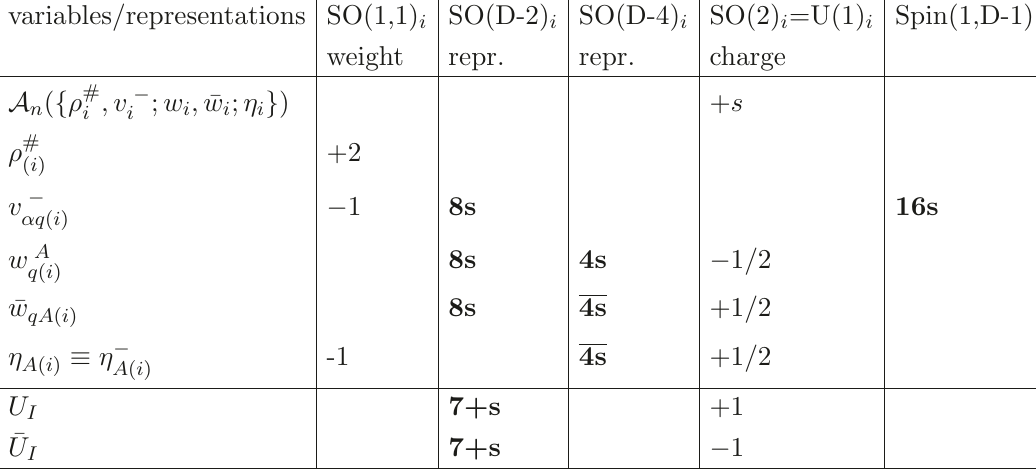
Table 1 . SO(D-4) and SO(D-2) representations, SO(1,1) weights and U(1) charges of the analytic superamplitude and its arguments; s = 1 for D=10 SYM and s = 2 for 11D SUGRA. U I and ¯ U I are bilinears of w and ¯ w as defined in (4.25) for D=10 and (5.41) for D=11. This table also indicates that the simplest superamplitudes (6.1) are Lorentz scalars, have charges + s with respect to all the U(1) i symmetry groups and are inert under all other bosonic symmetry transformations SO(1 , 1) i ⊗ SO( D − 2) i ⊗ SO( D − 4) i . As we will discuss below, the analytic superamplitudes also obey a set of equations with harmonic covariant derivatives which provide us with counterparts of the 4D helicity constraints